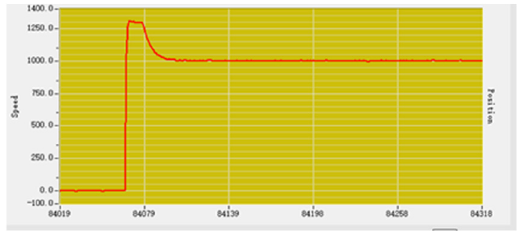
Figure 18. Proportional integral differential adjustment velocity curve.